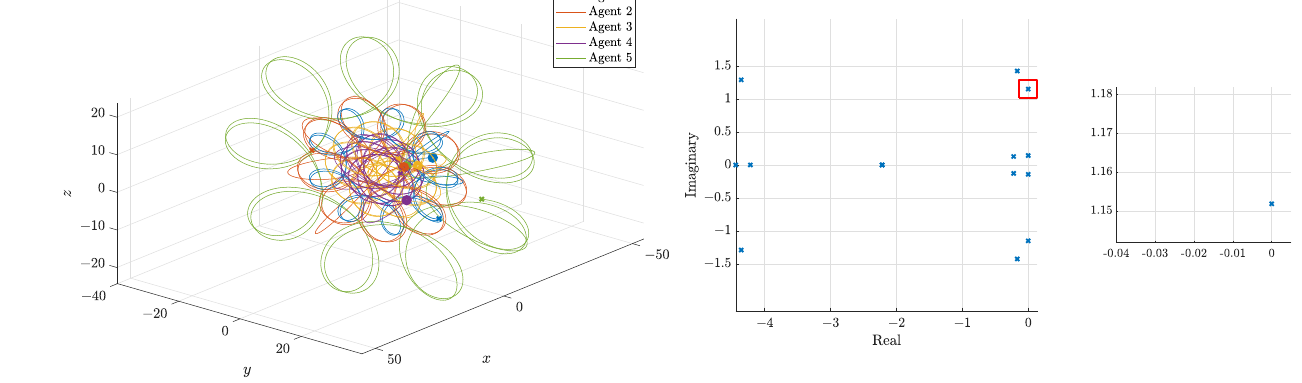
Figure 5. Reference patterns and eigenvalues repartition.